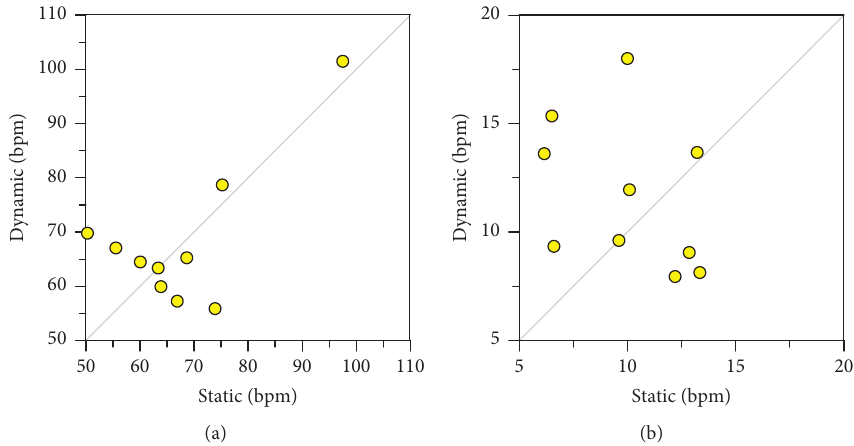
Figure 17: HR data (bpm) for the involved participants under static or dynamic VR setup: (a) average and (b) standard deviation.